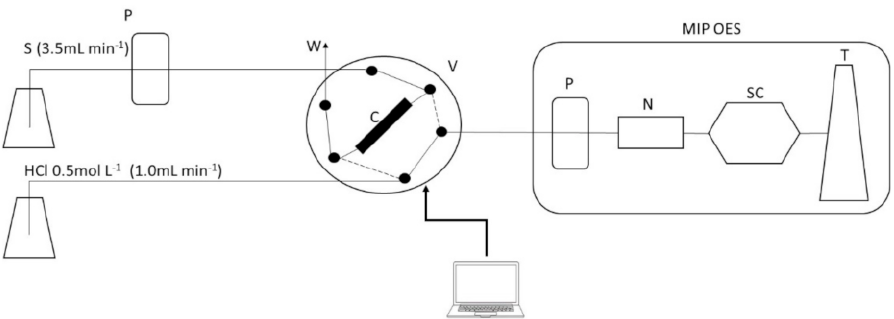
Figure 3. FI system for the on-line preconcentration coupled to MIP OES. P: peristaltic pump; V: 6-port injection valve; C: minicolumn; W: waste; S: sample or standard; HCl: hydrochloric acid for elution; N: nebulizer; SC: spray chamber; and T: torch. Dotted lines represent the valve position during the elution step and solid lines represent the position during the preconcentration step.